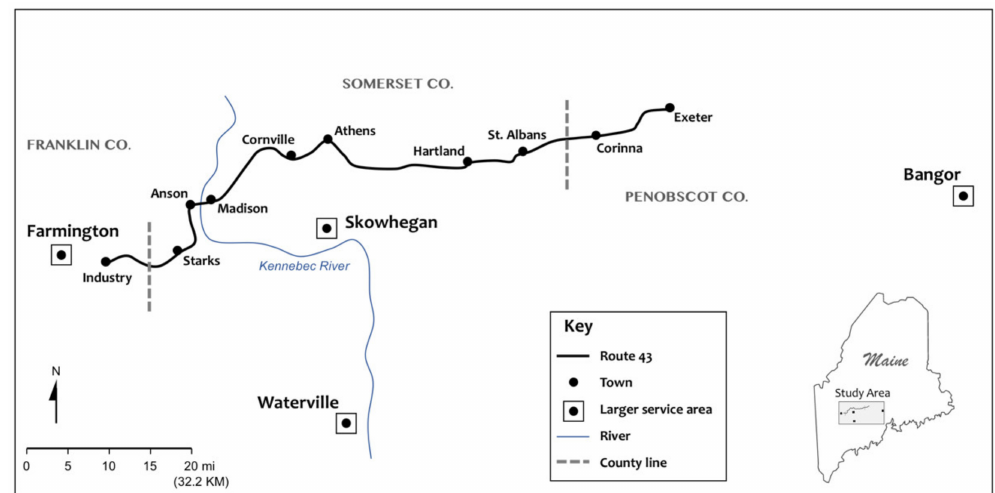
Figure 4. Map of transect across Central